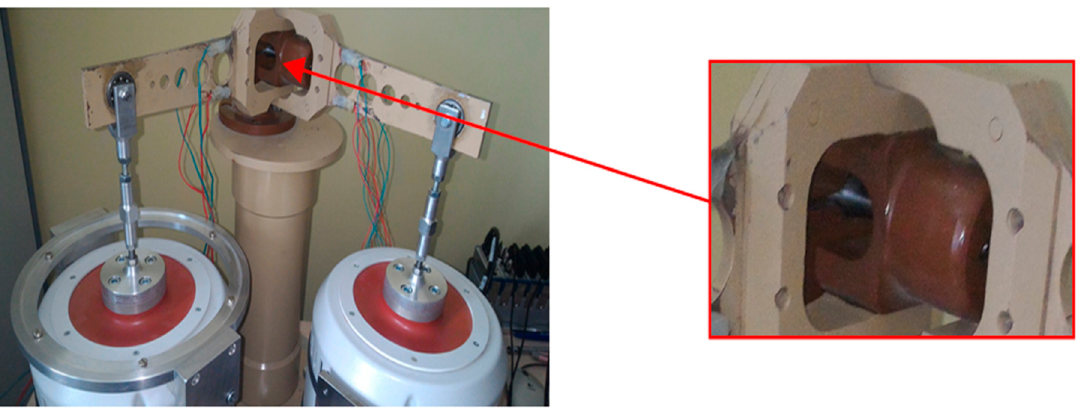
Figure 6. Test stand for tests with uniaxial and biaxial load. The image on the right shows a magnification of the position in which the specimen is clamped inside the stand.